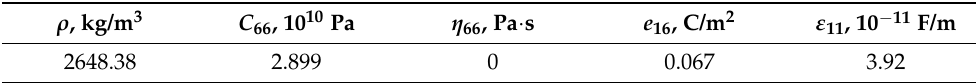
Table 1. The initial values of the quartz resonator material constants.